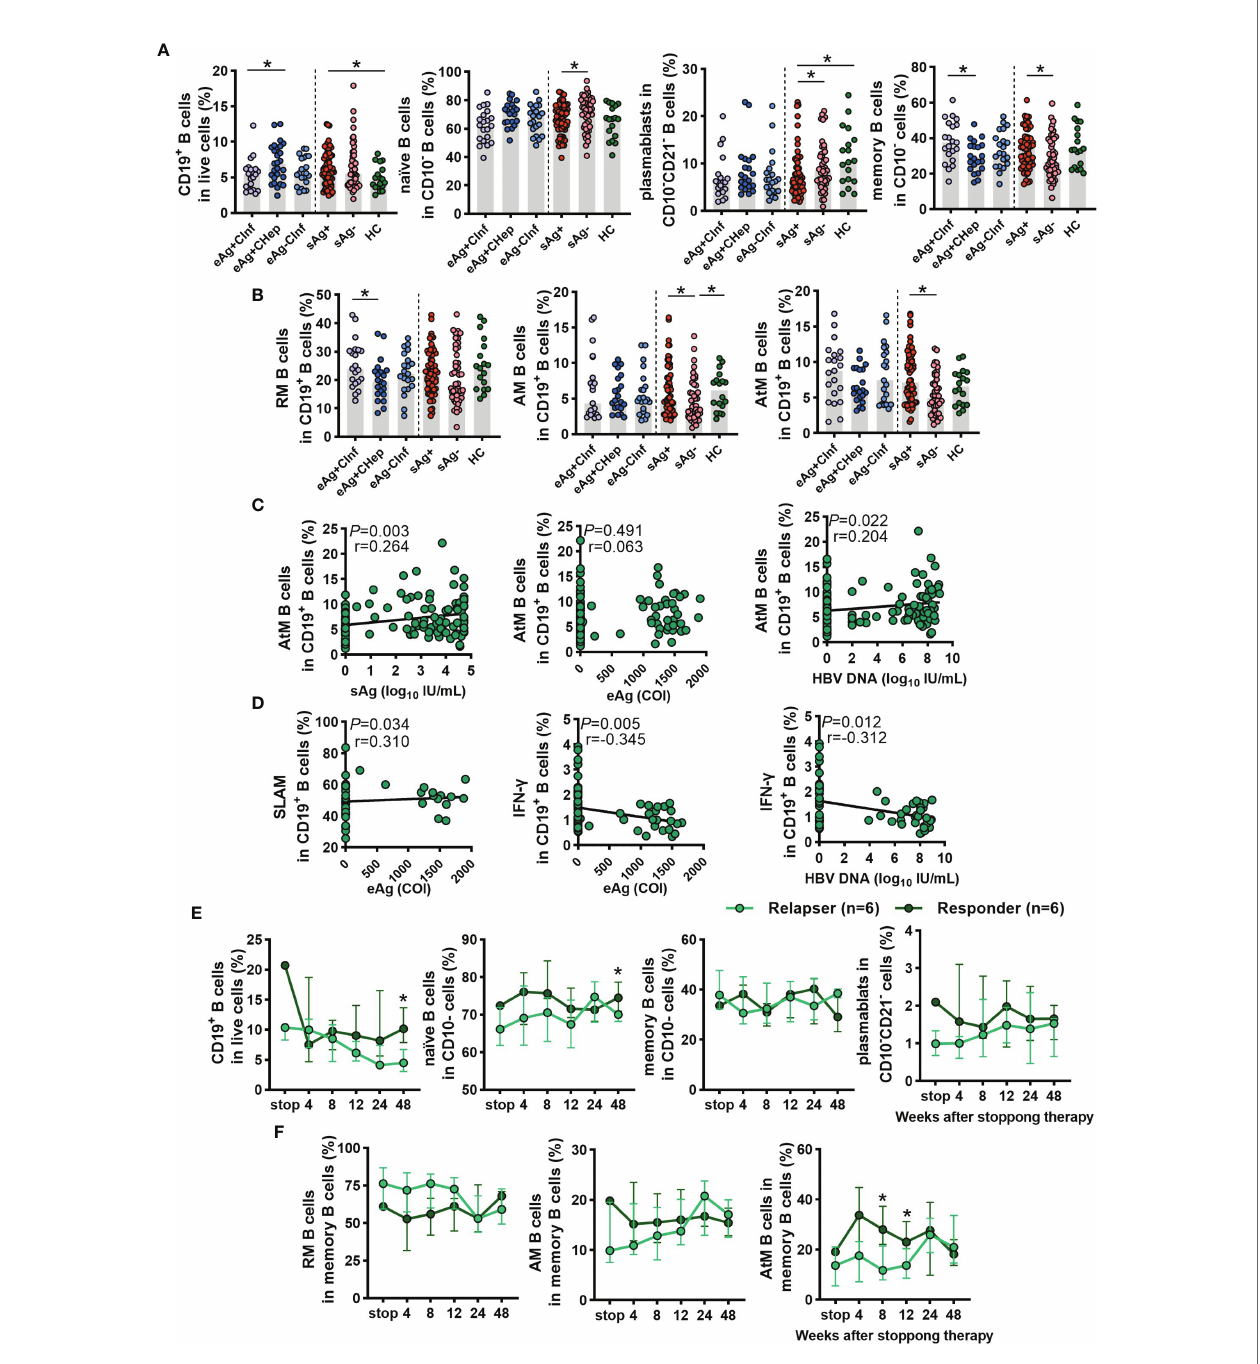
FIGURE 1 | Analyses of the B-cell subsets in the cross-sectional cohort and NUCs withdrawal cohort. (A) Comparison of the frequencies of total CD19 + B cells, naïve B cells, plasmablasts, and memory B cells in patients with chronic HBV infection and HCs. According to the EASL clinical practice guideline, these subjects were classi fi ed into 4 groups: hepatitis B e antigen-positive chronic infection (eAg + CInf, n=21), eAg-positive chronic hepatitis (eAg + CHep, n=21), eAg - CInf (n=21), and hepatitis B surface antigen-negative (sAg-, n=46). (B) Frequency of resting memory (RM), activated memory (AM), and atypical memory (AtM) B cells among CD19 + B cells in HBV patients and HCs. (C) Spearman ’ s correlation between the frequency of AtM B cells among CD19 + B cells and the levels of serum virological parameters. (D) The correlation between the expression of SLAM and IFN- g on CD19 + B cells and the levels of serum virological parameters. (E, F) Longitudinal analysis of B-cell subsets after stopping NUCs therapy. (A, B) Kruskal – Wallis H test and Dunn ’ s multiple comparisons test. (C, D) Spearman ’ s rank correlation test. (E, F) Mann – Whitney U test. * P <